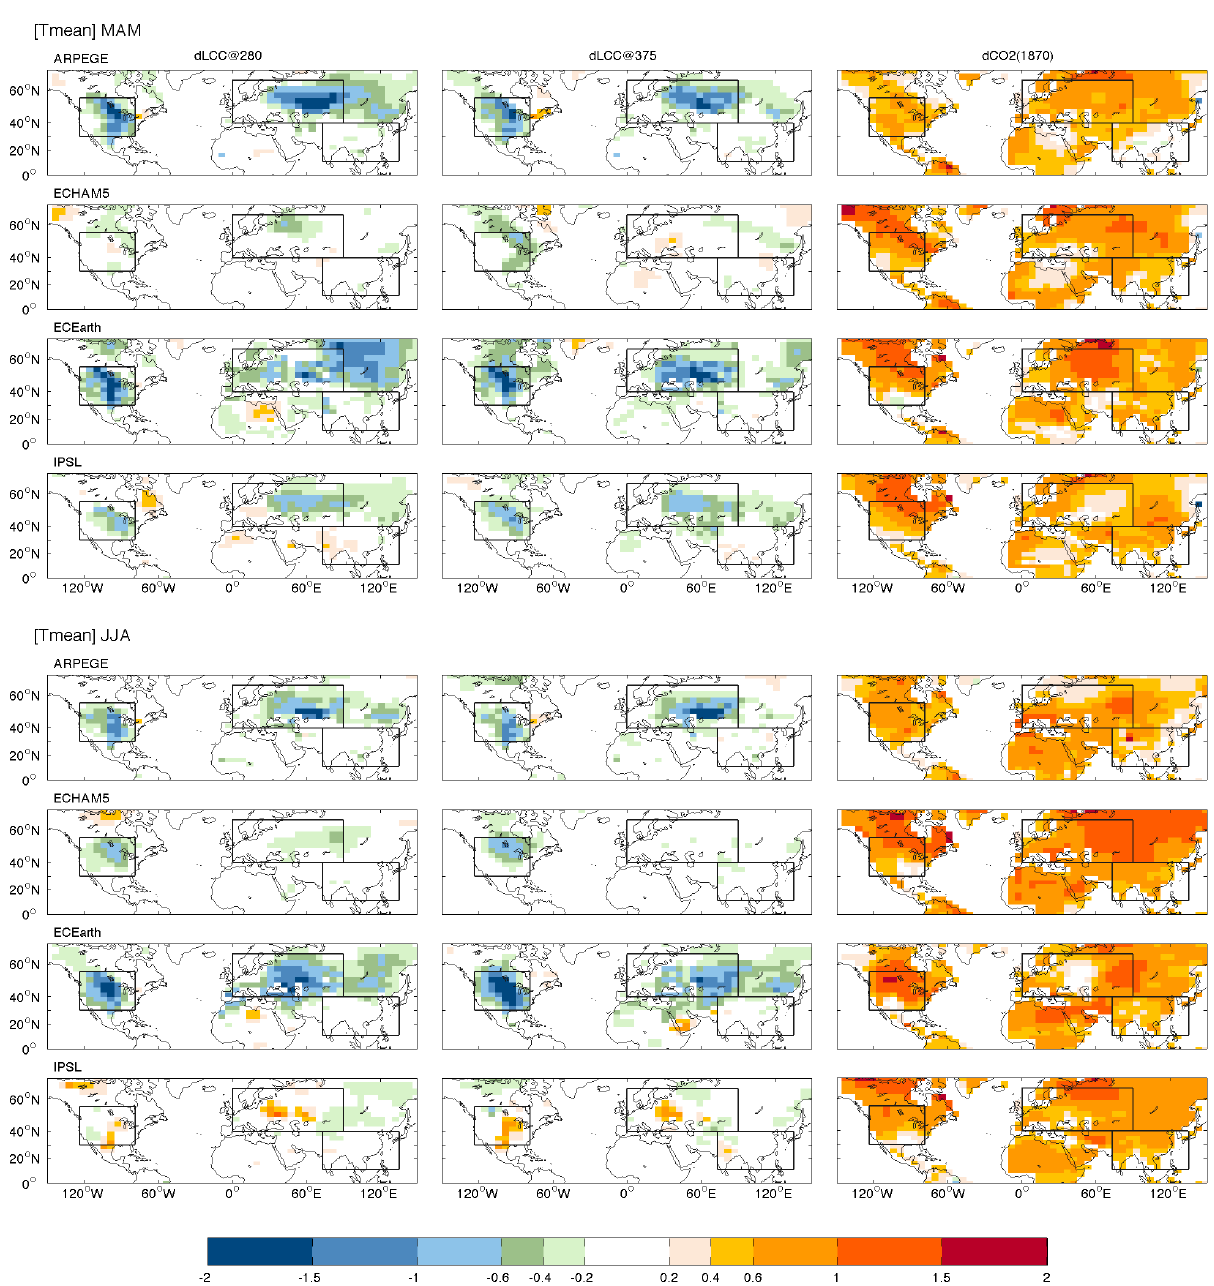
Fig. 2. Change in the mean surface air temperature ( ◦ C) in March-April-May (MAM) and June-July-August (MAM) for the four models. The left column is the impact on the mean surface air temperature of LULCC at a CO 2 concentration of 280ppmv (PIv-PI). The middle column is the impact of LULCC at a CO 2 concentration of 375ppmv (PD-PDv). The right column shows the impact of the increase in CO 2 alone using land cover reflecting 1870 conditions